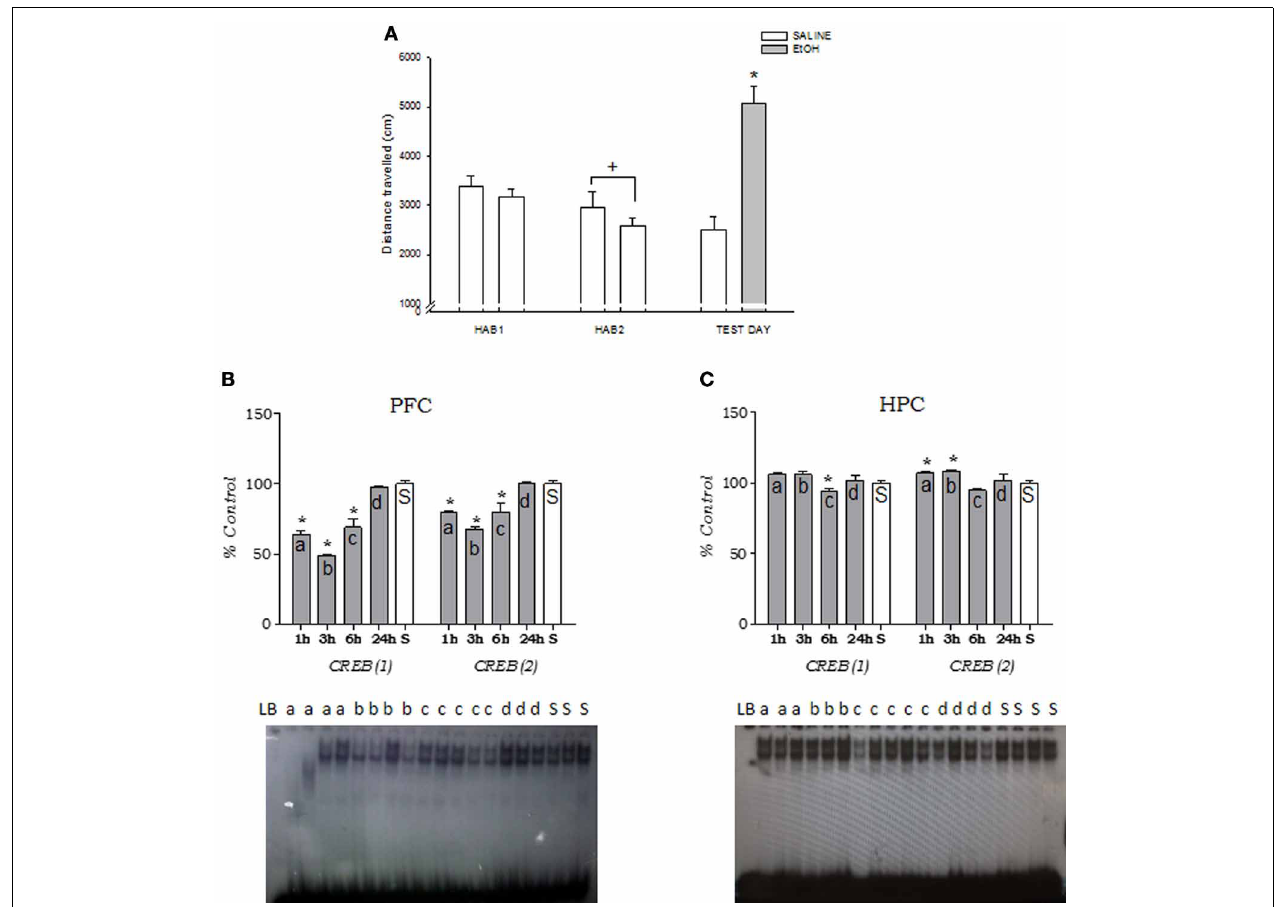
FIGURE 1 | (A) Stimulant effects of an acute ethanol injection (2.0g/kg) on locomotor activity in adult mice. Habituation H1 and H2 were analyzed using an ANOVA, followed by Newman-Keuls test; + p < 0 . 05, H2 < H1. The data for the Test Day were analyzed using a t -test for independent samples; ∗ p < 0 . 05. Values are expressed as the distance traveled (cm) ± s.e.m. (SALINE n = 8; EtOH n = 20). (B) and